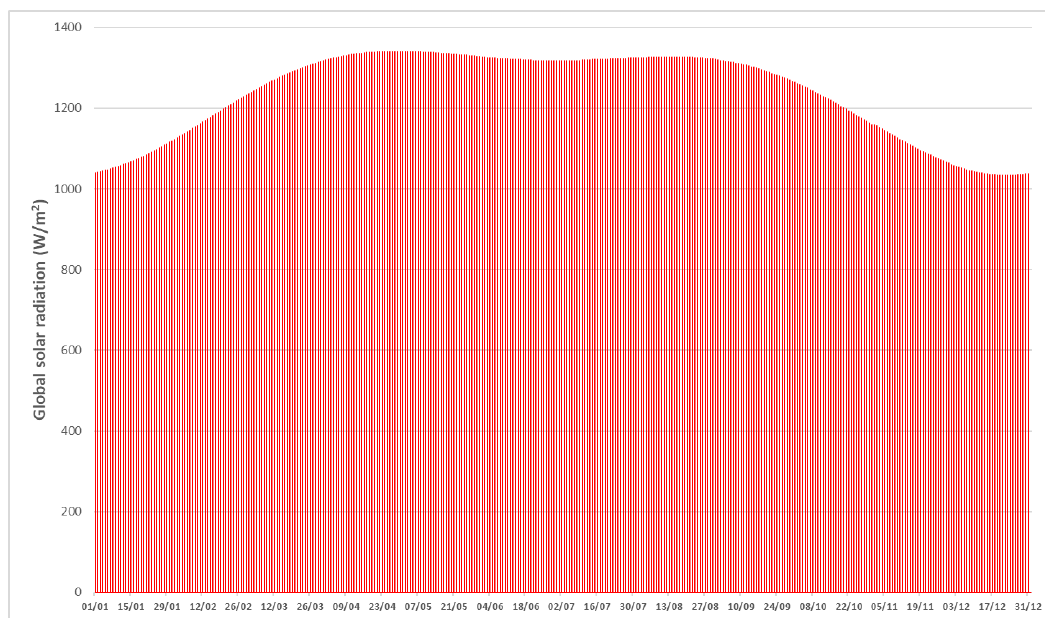
Figure 5. Hourly global solar irradiance of the TMY of Mexico City based on its EPW files.